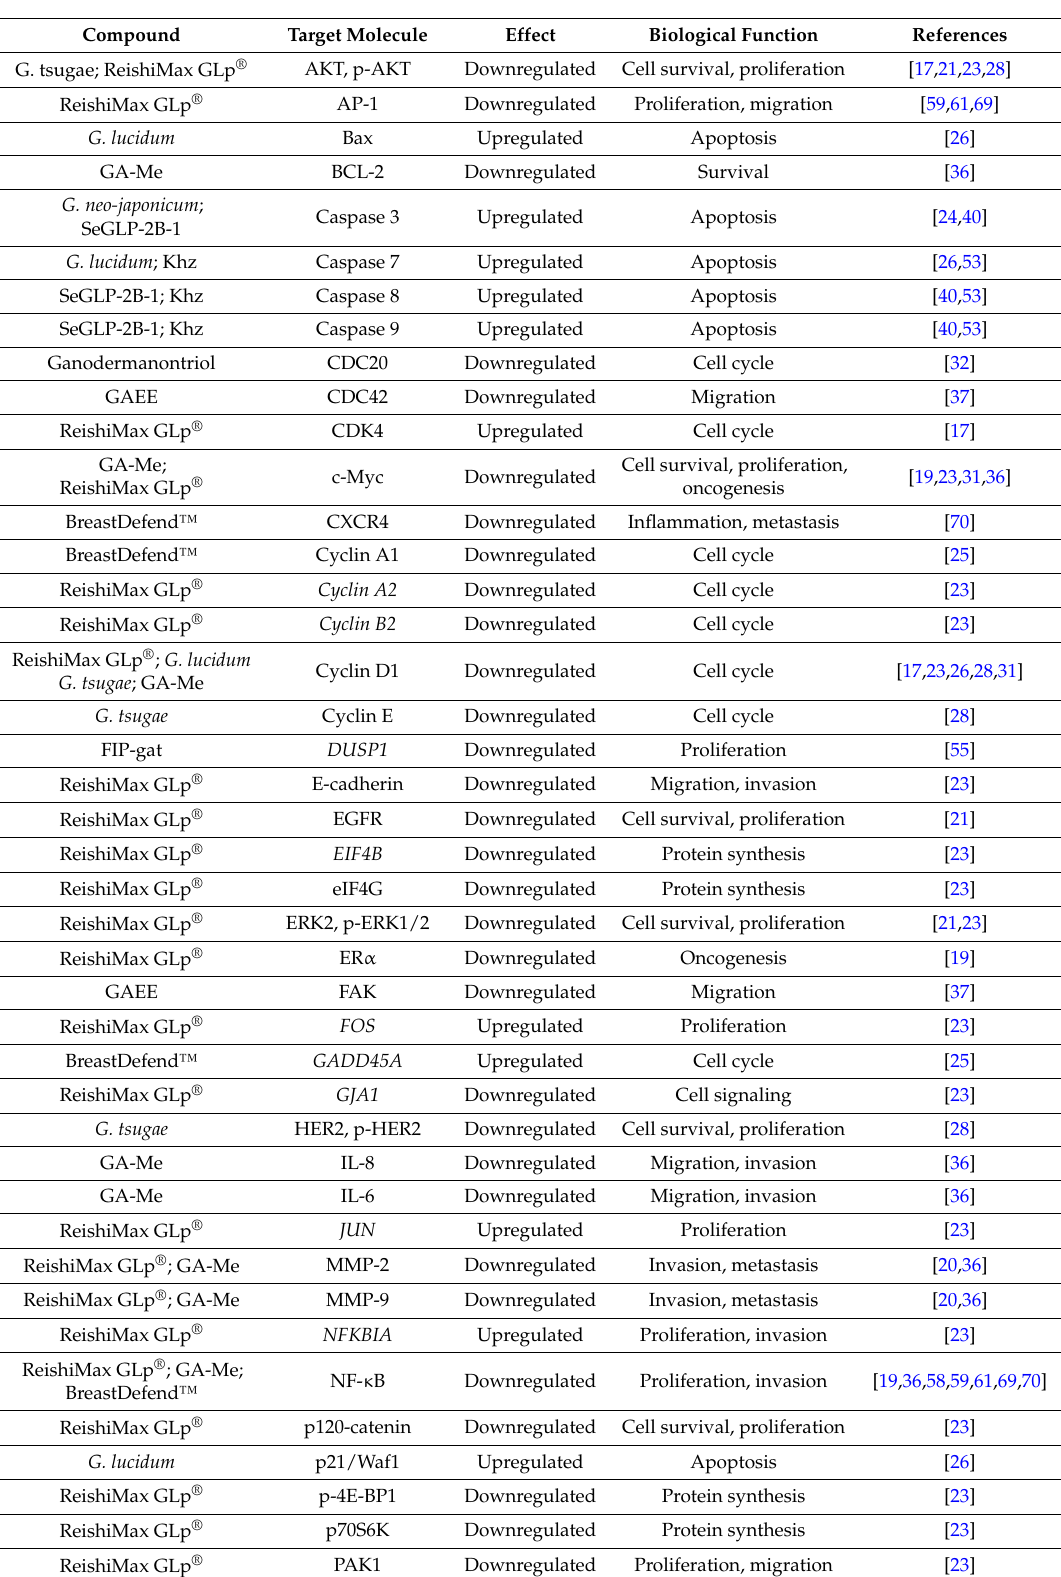
Table 2. Anti-breast-cancer mechanisms of Ganoderma spp. FIP, fungal immunomodulatory protein; ESAC, ethanol-soluble and acidic